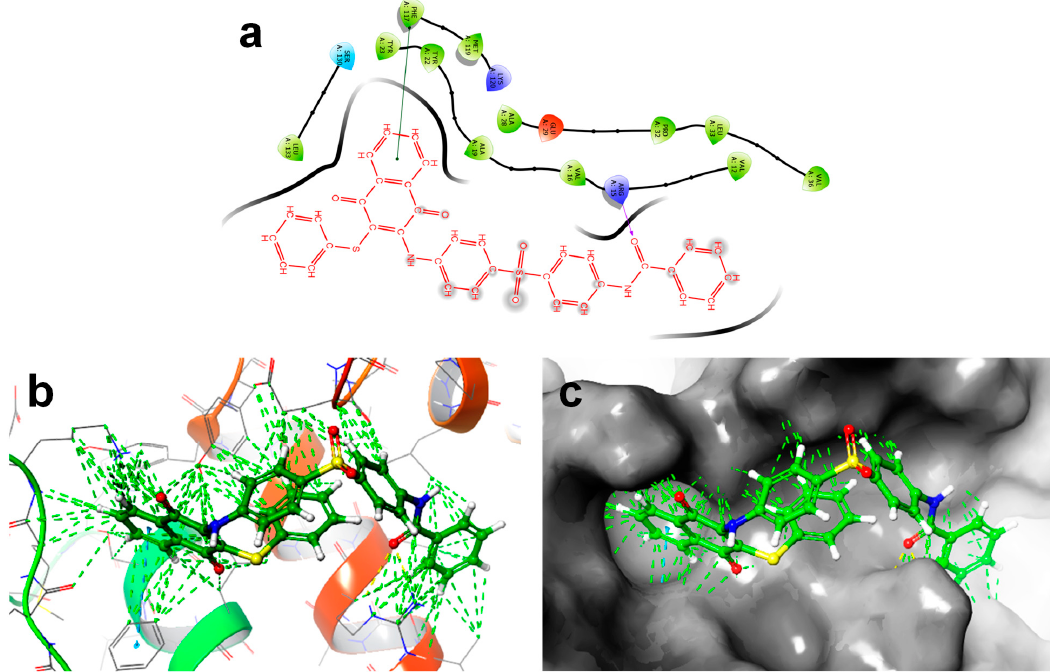
Figure 6. (a ) 2D docking interaction of 5a with the active site of 3CW0. ( b ) 3D docking of 5a (S = − 2.636 kcal/mol) in the active site of 3CW0. ( c ) Docking packing representation of 5a with suitable binding pockets of 3CW0.